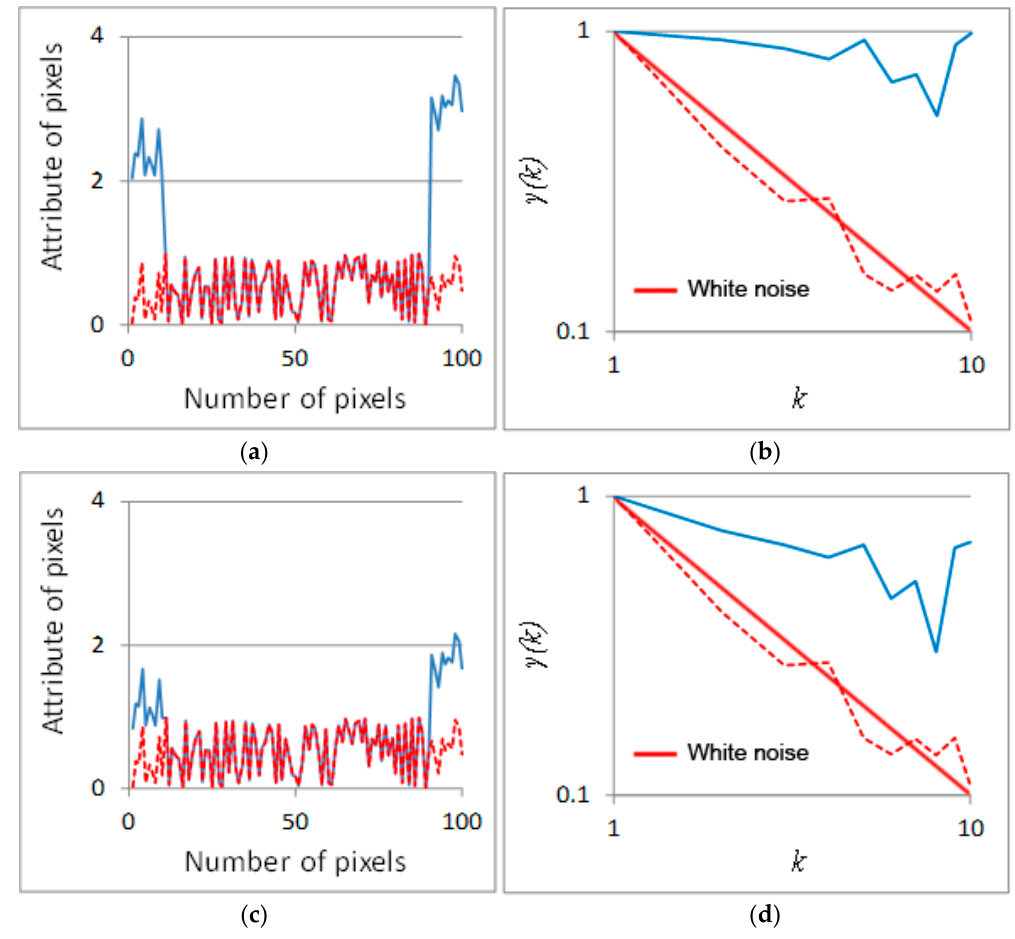
Figure 2. ( a , c ) Examples of data series with different statistical characteristics in one dimension; Colum ( b , d ) Standardize climacograms of data series of ( a , c ).